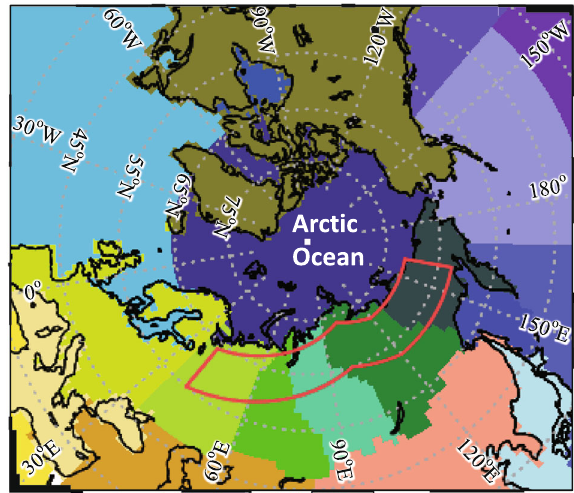
Fig. 1 De fi nition of moisture source regions. Colors are assigned to regions where evaporated water is investigated. The Arctic Ocean is colored navy blue. The red line denotes the area used for the cross section shown in Fig. 2.